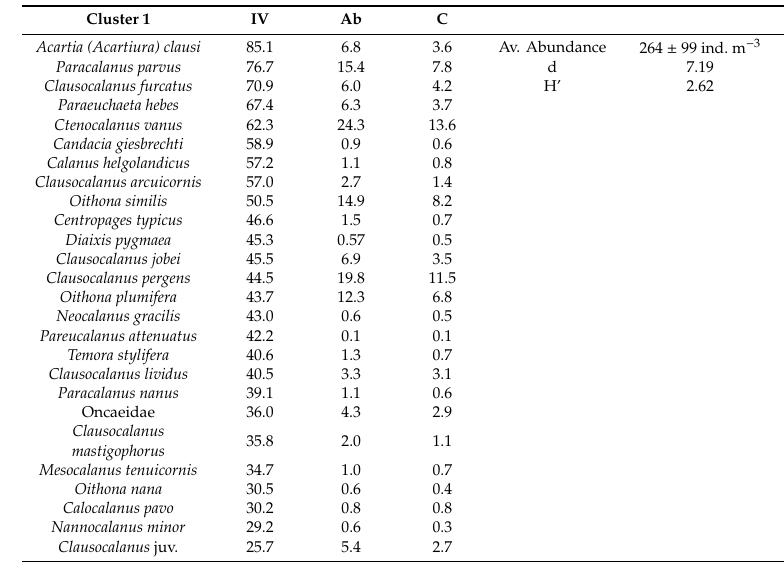
Figure 6. Vertical and horizontal distribution of the cluster groups over the investigated SA transect in December ( a ) and April ( b ); eastern coastal station: E-13, eastern midshelf station: E-12, eastern south central stations: E-09 and E-10, western south central stations: E-GG, E-07, and E-05, western midshelf stations: E-03 and E-20, and western coastal stations: E-01, E-16, and E-18. Table 3. Copepod taxa that characterize the five clusters identified by the hierarchical clustering with the indicator values (IV), average abundance (Ab-ind. m − 3 ), and average contribution (C-%). Information on each cluster (average abundance, species richness, and diversity) are